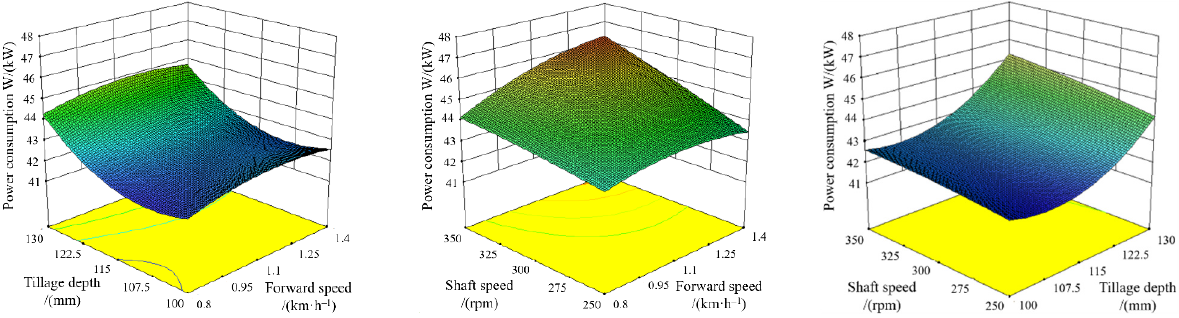
Figure 20. Response surface variation relationship of influencing factors on the power consumption.